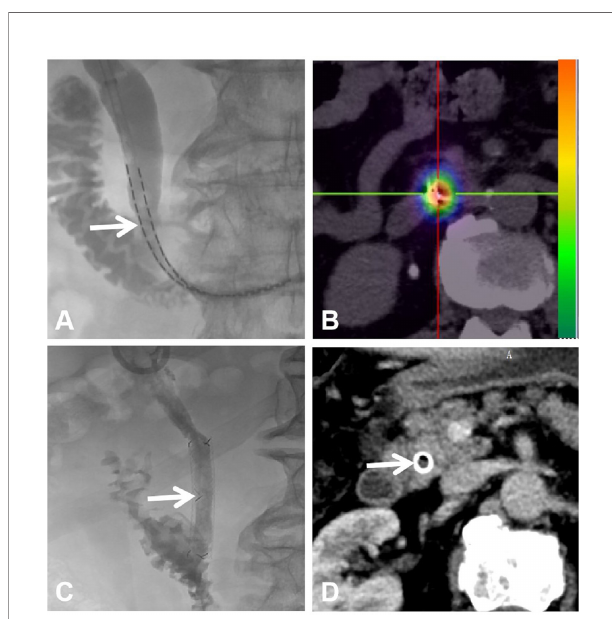
FIGURE 4 | Placement of the brachytherapy drainage catheter and stent patency after 9 months. (A) The brachytherapy drainage catheter was inserted across the PC to the duodenum. (B) SPECT/CT scan showing radiation emitted by 125 I brachytherapy within the PC. (C) Biliary stent after brachytherapy showing stent patency. (D) CT scan showing stent patency at the 9-month follow-up.